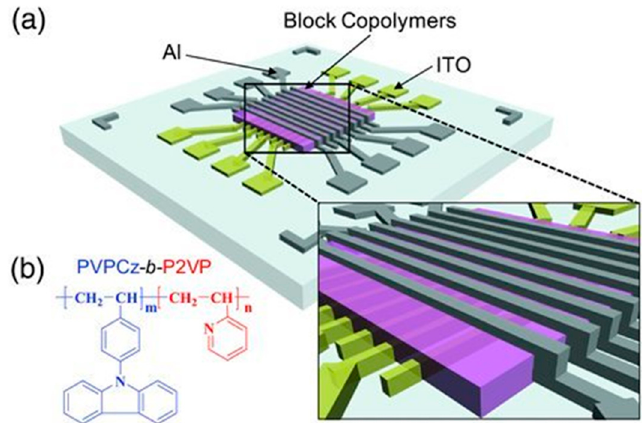
Figure 24. ( a ) A Scheme of the fabricated organic memory device (Al / polymer / ITO); ( b ) Structure of the block copolymer of PVPCz - b - P2VP. Reproduced with permission from [189]. Copyright (2011) Wiley.